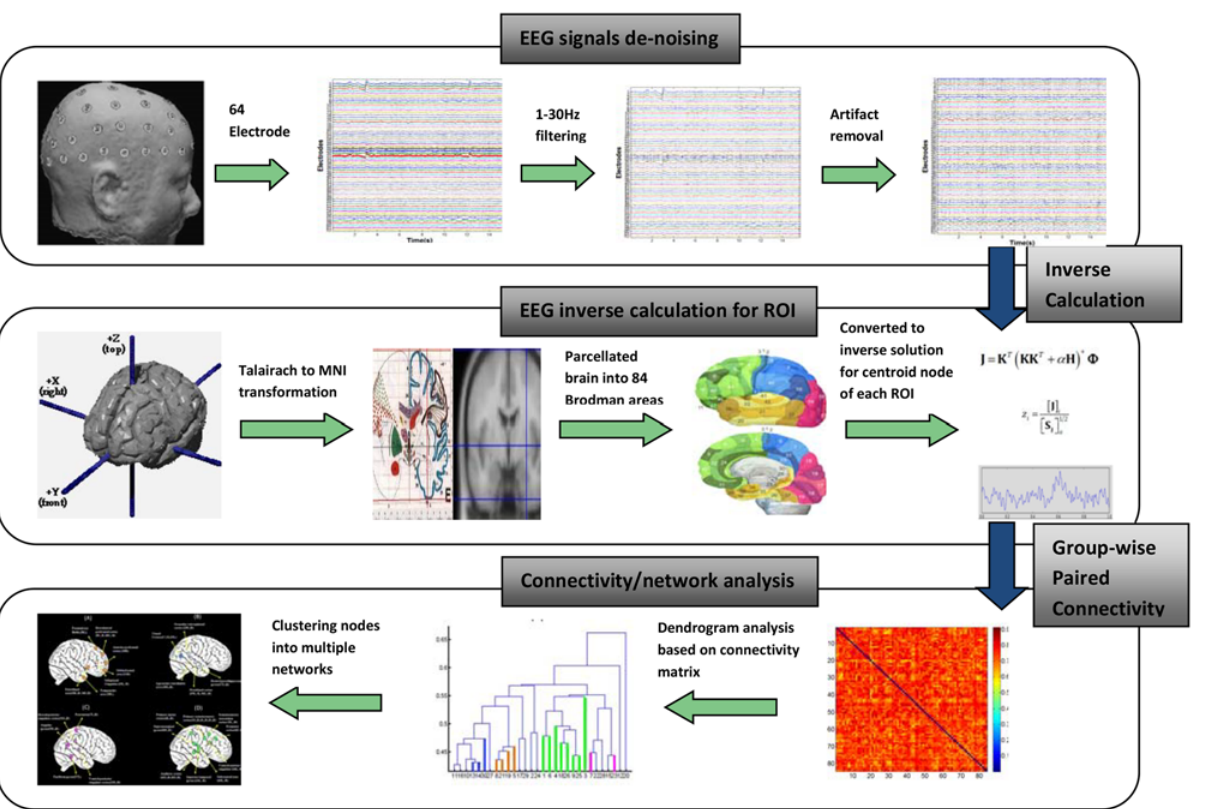
Figure 2. The descriptive steps of analysis from input EEG raw signal to the output network. The ‘ EEG-signal ’ segment dealt with band-pass filtering (1 – 30Hz) as well as artifact (EOG & EMG) removal of raw EEG data (output ‘ clean ’ EEG data); the ‘ EEG inverse calculation for ROI ’ mainly mapped the ‘ clean ’ EEG into source space on centroid voxel that is most representative of the 84 ROIs to retrieve source time series; the pair-wise connectivity was calculated based on the 84 ROI ’ s time series into a 84×84 matrix, and then a group-wise connectivity matrix underwent dendrogram analysis that clusters 84 nodes into groups of sources, among which 4 common networks for the IL and IT conditions were identified and mapped onto a generic cortex model.